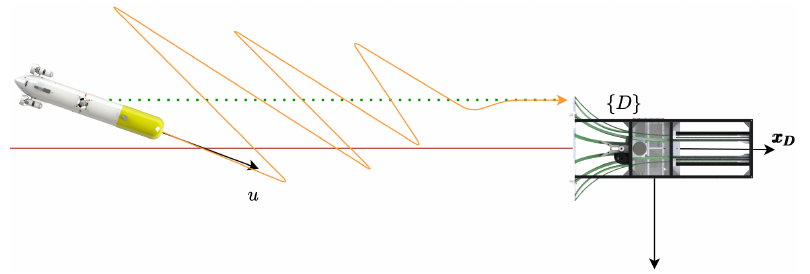
Figure 14. Conceptual performance representation.